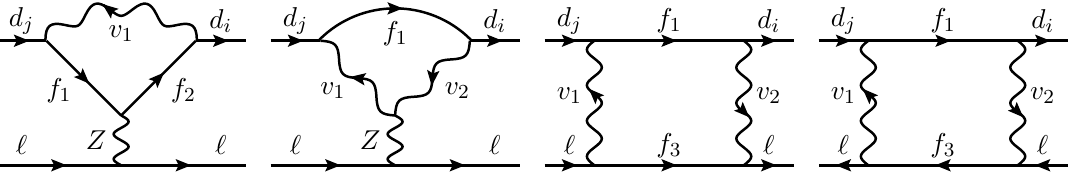
Figure 2 . Diagrams that directly match onto the ∆ F = 1 current-current operators. Here only contributions of internal massive vector bosons and fermions is shown. In addition, there is a finite contribution from the off-diagonal fermion self-energy diagram. The contribution of massive vector bosons and their related Goldstone bosons are denoted by a wavy